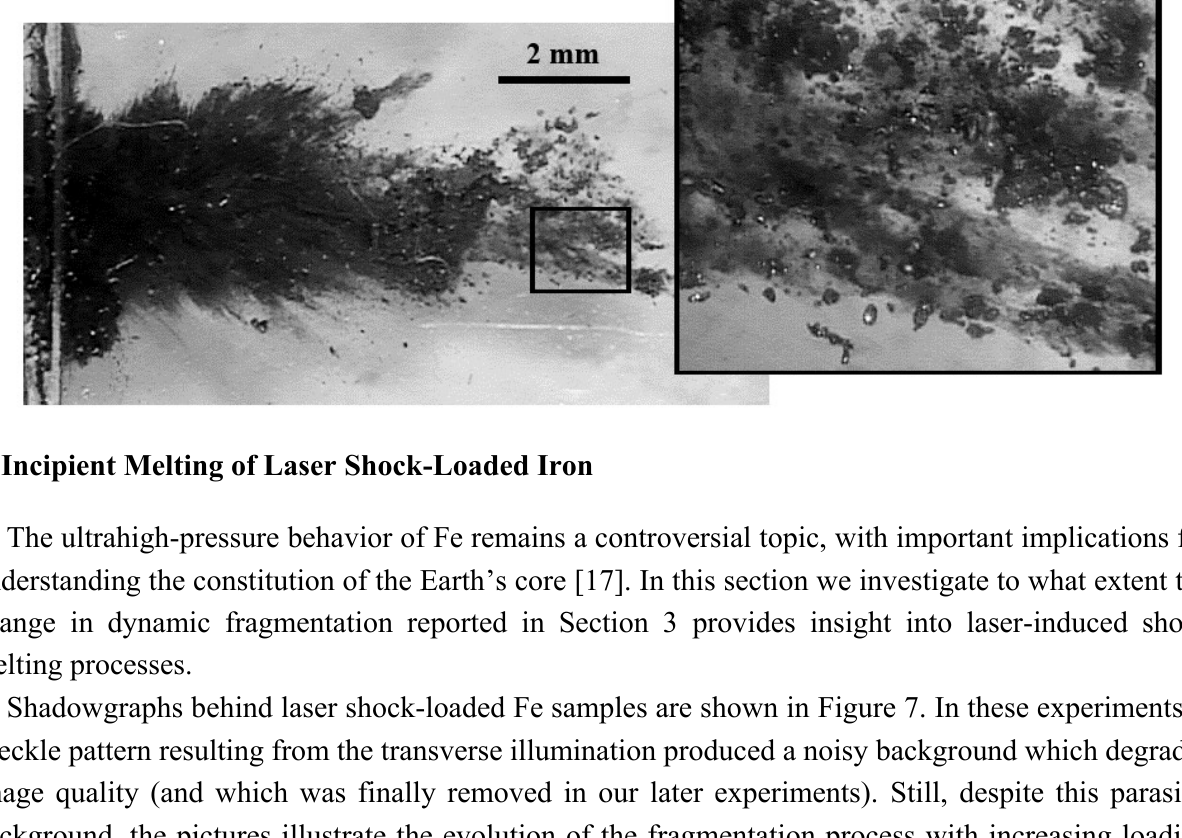
Figure 6. Optical micrograph of the fragments collected in a gel behind a 50 µm-thick Al sample subjected to a laser shock of 7.1 TW/cm 2 intensity, and closer view of the black frame (inset to the right ), showing spherical Al particles indicative of melting.